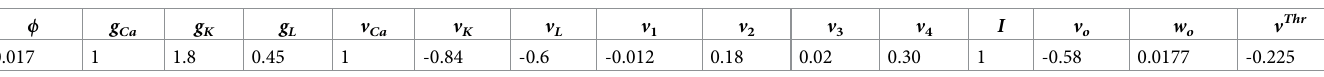
Table 1. The dimensionless parameters used to solve model Eqs